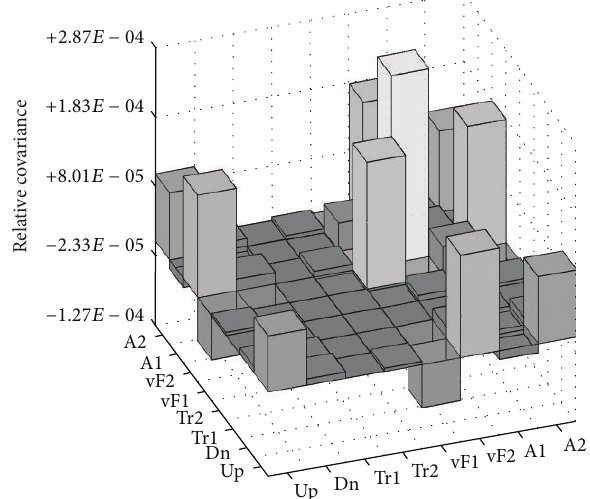
Figure 30: Homogenized property covariance due to 𝜎 U 235 𝑓 covari- ance using FCWG.